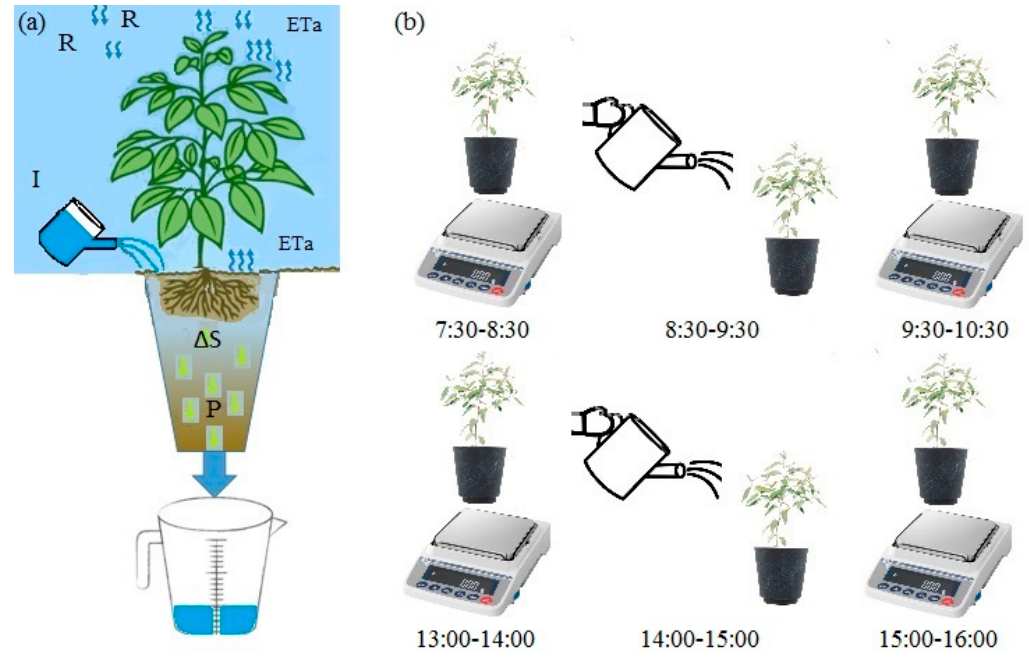
Figure 3. ( a ) Water balance components in lysimeter measurements of actual evapotranspiration (ET a ), where R is rainfall, P is percolation, and I is irrigation, and ( b ) daily measurement and irrigation schedule in the